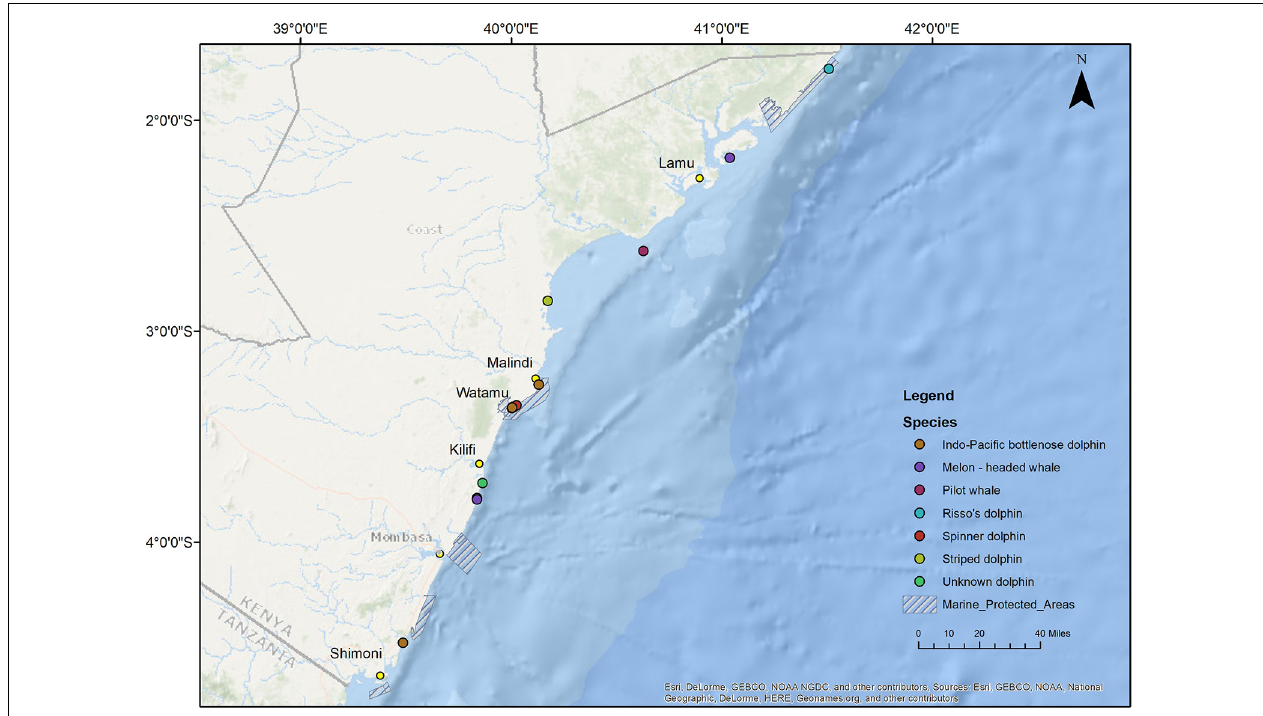
FIGURE 9 | Locations of stranded small cetaceans reported along the Kenyan coast between 2011 and